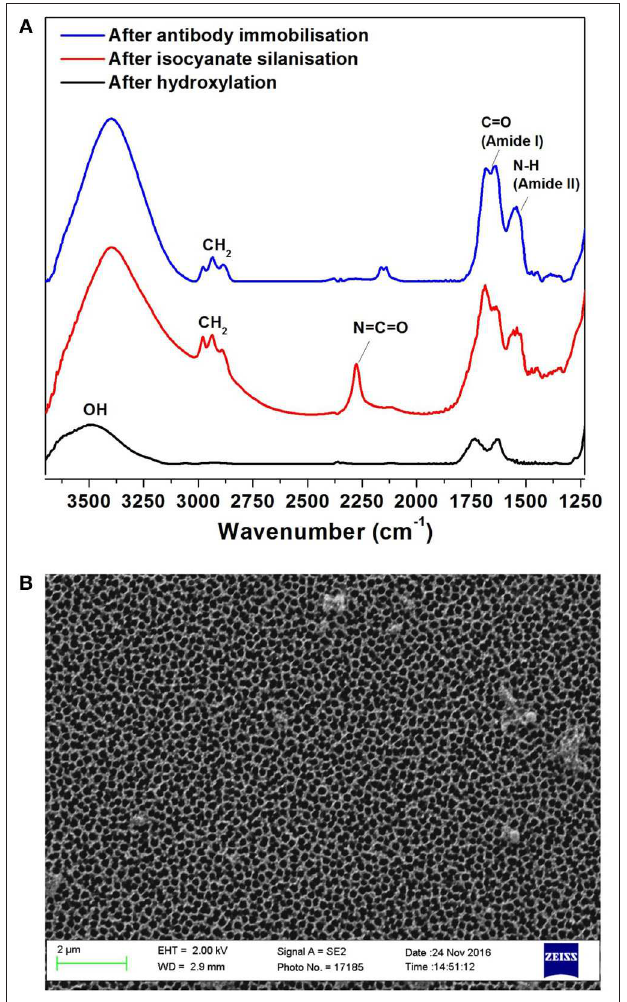
FIGURE 2 | FTIR spectra of NAA immunosensing surface at different modification steps: after hydroxylation (black), silanization (red) and Ab1 immobilization (blue) (A) , and SEM top-view image of NAA (B) .